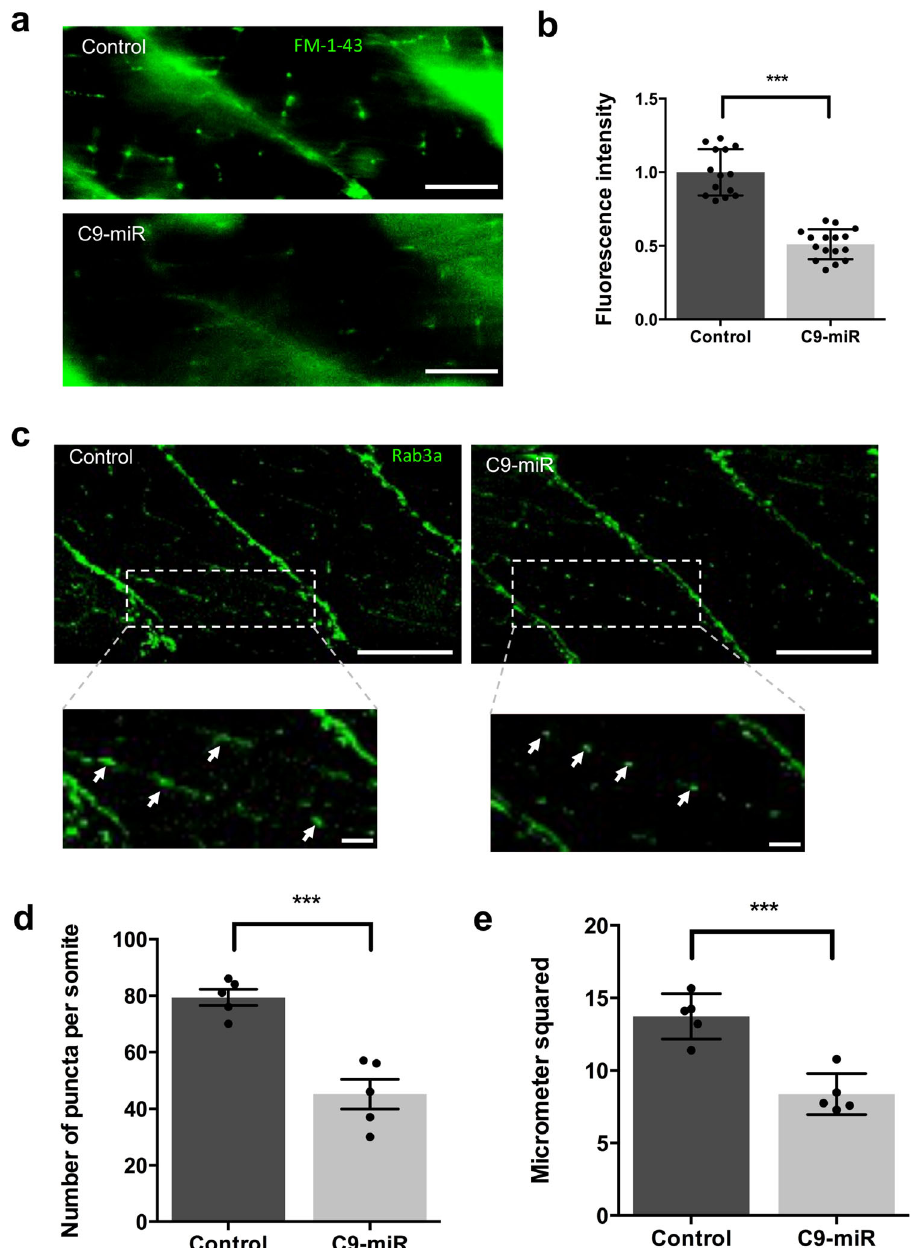
Fig. 8 C9orf72 regulates synaptic active zones and activity at the neuromuscular junction. a FM1-43 loading of NMJ boutons in 6 dpf fi sh. C9-miR fi sh displayed decreased FM1-43 loading compared to controls. b Quanti fi cation of FM1-43 fl uorescent intensity in control ( n = 14) and C9-miR fi sh ( n = 16), showing a reduced FM1-43 fl uorescent intensity in C9-miR fi sh ( p < 0.0001; Student ’ s t test). c Putative synapses (arrows) were visualized with Rab3a immunostaining at 6 dpf (inset; scale bar = 10 μ m). Rab3a + synaptic puncta were reduced in number ( d ) and area ( e ) in 6 dpf C9-miR larvae when compared with wild-type controls ( n = 5; *** p < 0.0001; Student ’ s t test). Scale bar = 50 μ m. Data are presented as mean ± SEM. n represents the number of fi